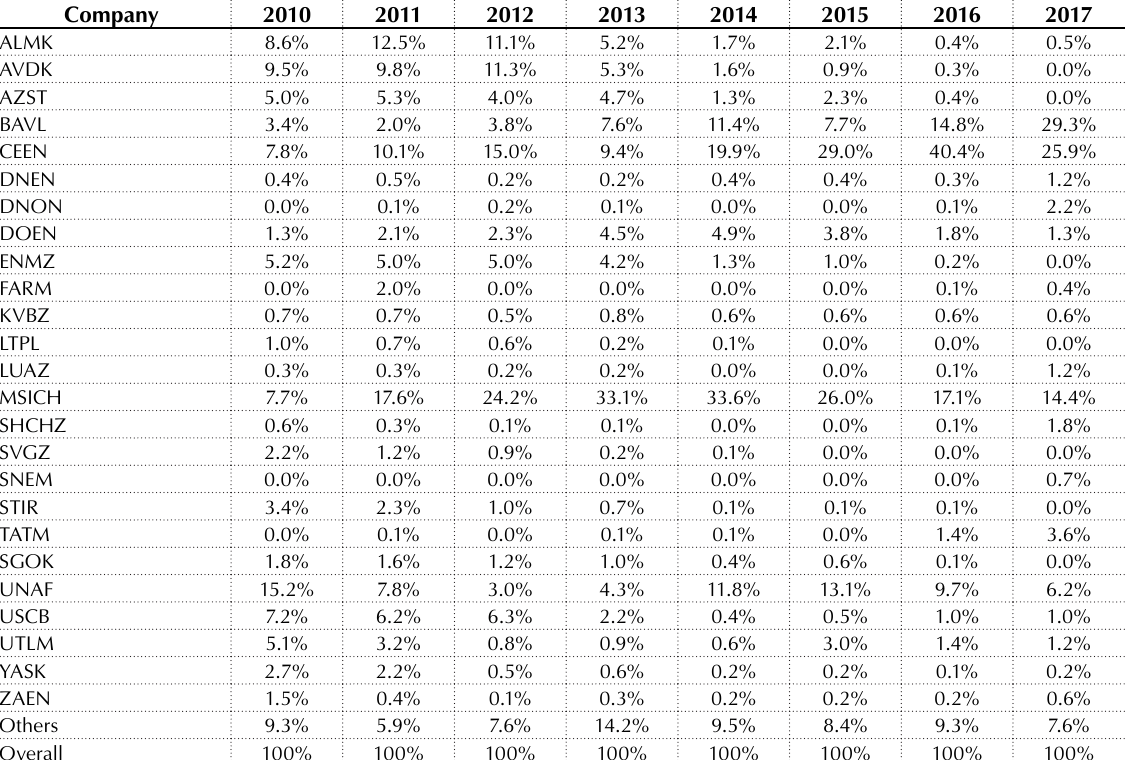
Table A1. Structure of the trades in the Ukrainian Exchange during 2010–2017 Company